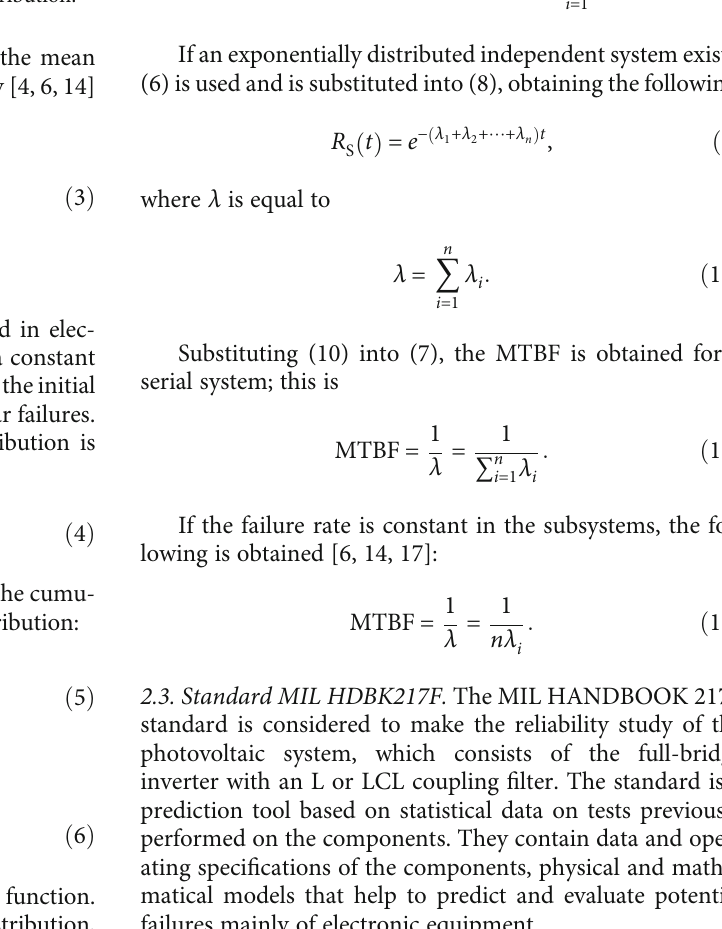
Figure 3: Constant failure rate of the exponential distribution.